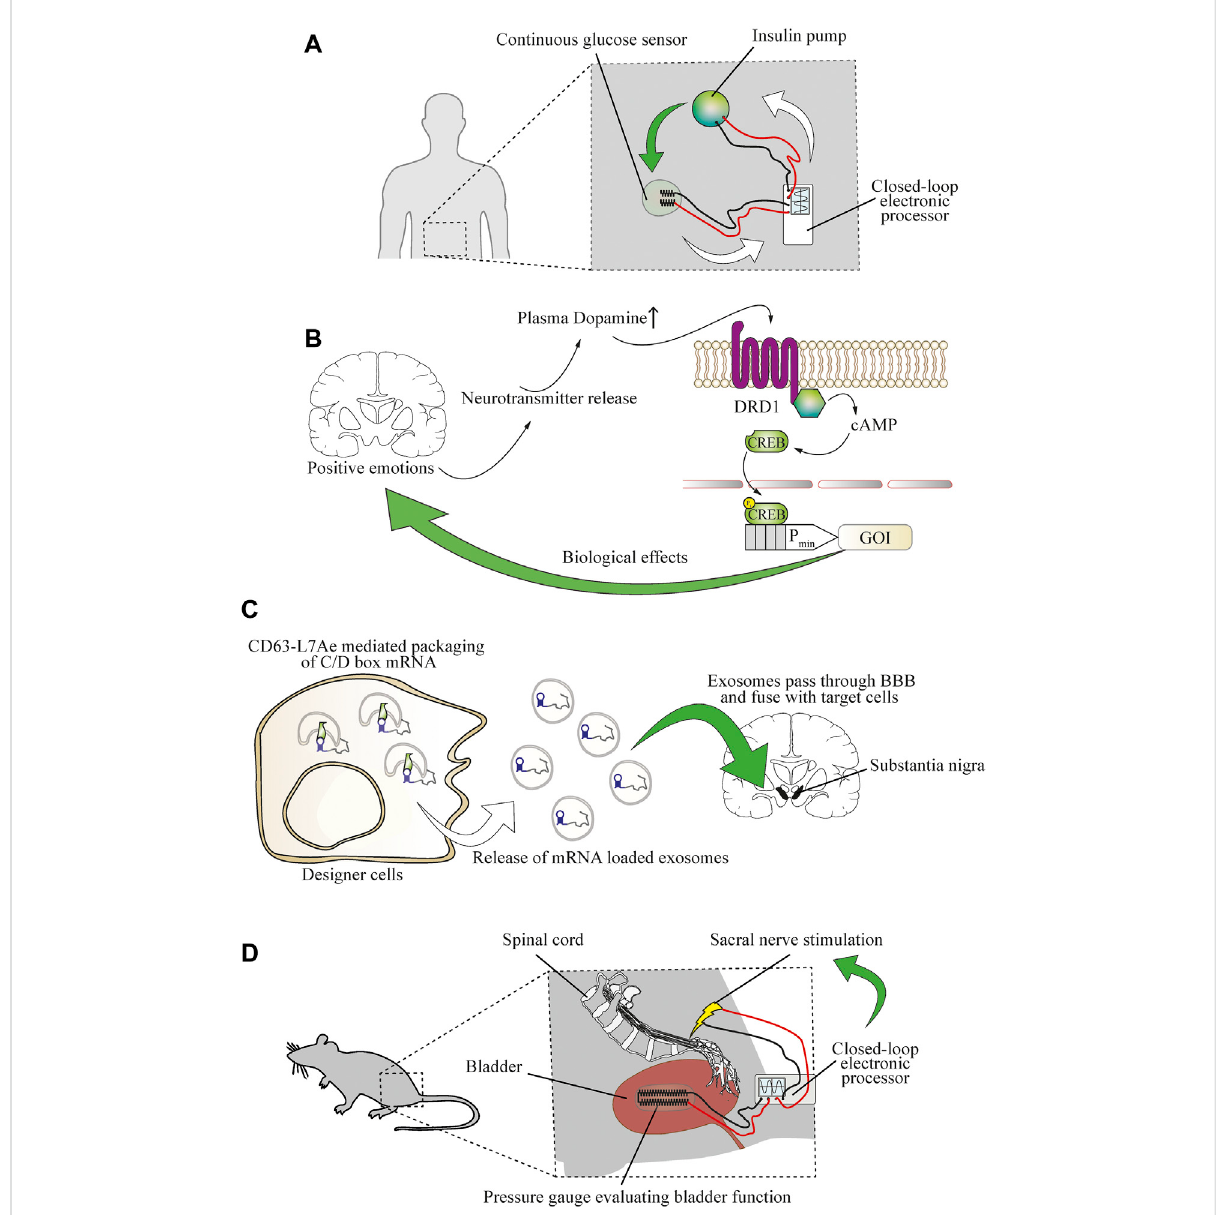
FIGURE 6 Establishing direct bidirectional electronics-to-physiology connections that would enable cellular therapies for neurological diseases. (A) Coupling of physiological parameterssuch as glucoseconcentration to electronic devices is possible and enables electronic closed-loop control of glycemia. A continuous glucose sensor evaluating glycemia sends information to awearable electronicprocessing device that controls thefunction of an insulin pump. Upon release of insulin, glycemia is decreased, and the decrease is detected by the glucose sensor, causing the controller devicetoreducethefunctionoftheinsulinpump.Redandblacklinesindicatewiring. (B) Themolecularpatternsofspeci fi ctypesofbrainactivitycan bedetected by engineered cellular implants. Positive emotions, such as sexual arousal, wereused to reroute neurotransmitter release in thebrain to establish direct control over cellular implants in the periphery. The DRD1 GPCR is activated by increased blood dopamine levels and triggers cAMP signaling, resulting in phosphorylation of CREB and expression of a gene of interest (GOI) under its control. (C) Engineered cellular implants can deliver therapeutics directly to the brain. An exosome delivery strategy enables treatment of neuroin fl ammation by engineered therapeutic cells in a mouse model of Parkinson ’ s disease. The mRNA encoding for the therapeutic protein is tagged with a C/D box sequence that is recognized by a CD63-L7Ae fusion protein, enabling packaging into lipid bilayer vesicles. Upon release into the bloodstream, the exosomes pass the blood-brain barrier (BBB) and deliver the mRNA cargo to target cells in the brain. (D) Coupling of physiological functions to electronic devices enables closed- loop control over urinary incontinence. An implanted electronic gauge constantly measures the pressure in the bladder to evaluate its function. The signal is transferred to an electronic processor device that induces stimulation of the sacral nerve to prevent overemptying of the